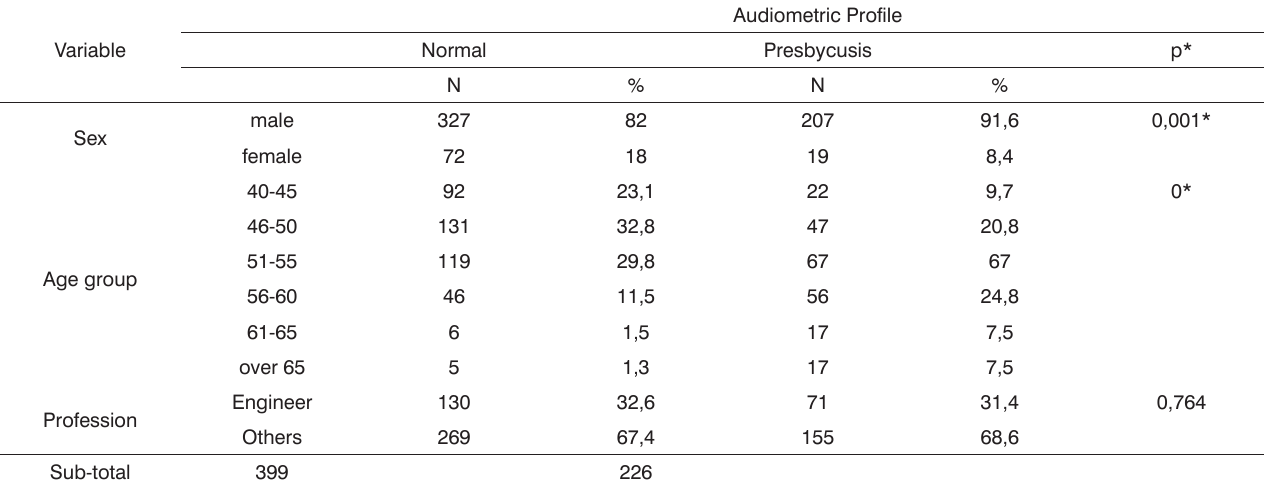
Table 1. Social and demographic features of the sample and the audiometric profile.